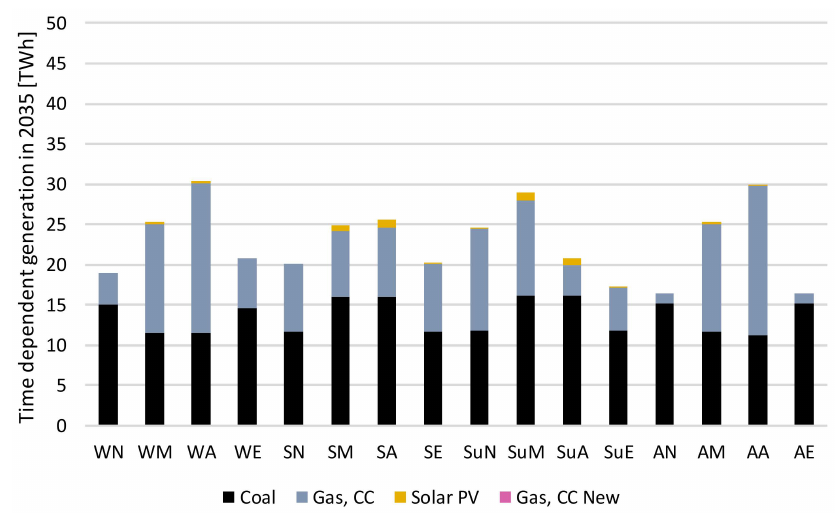
Figure 5. Generation (TWh) per time slice in 2035 in REF scenario—without code modifications.